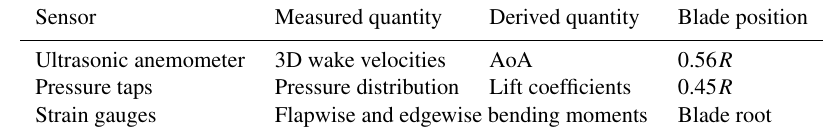
Table 3. Measurement methods and quantities.